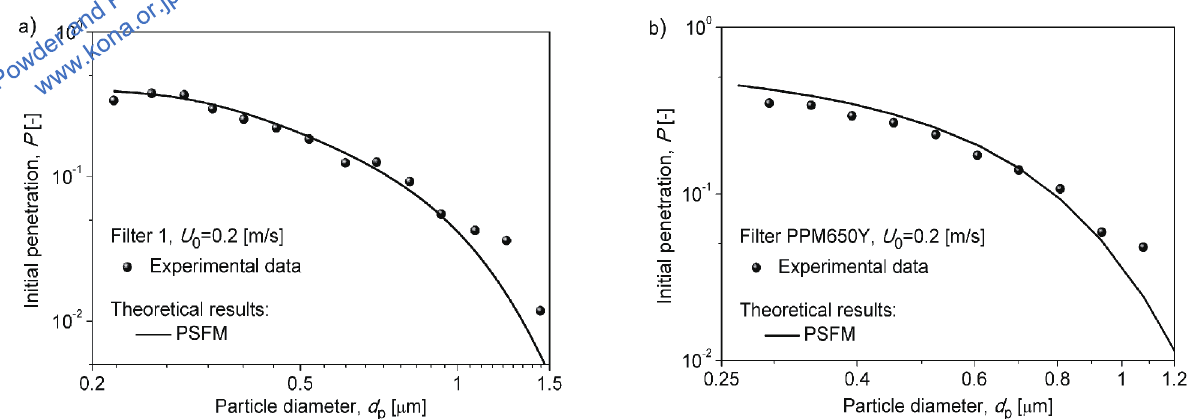
Fig. 8 Partially Segregated Flow Model predictions vs. experimental data of penetration for: Filter 1 (a) and Filter PPM650Y